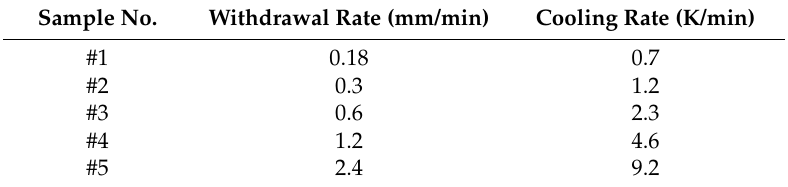
Figure 1. Phase diagram of GH4720Li superalloy. Table 2. Experimental scheme.